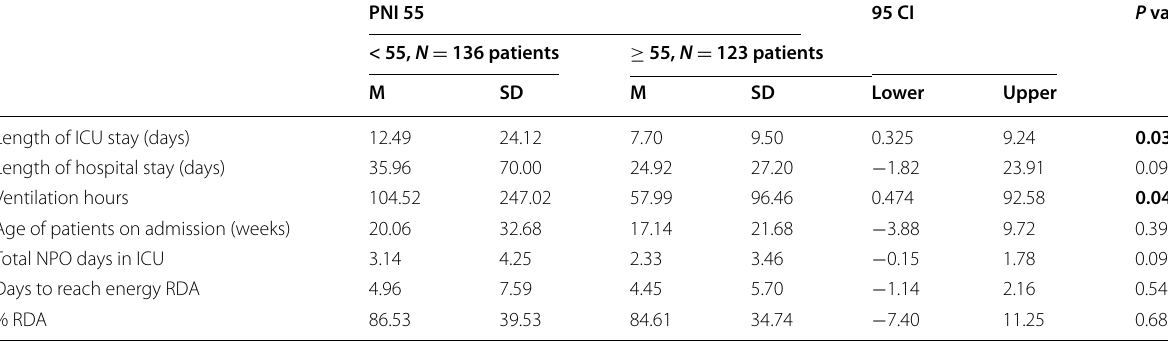
Table 4 Relationship between PNI 55 and continuous risk